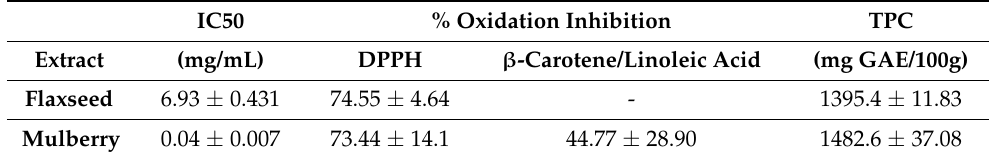
Antioxidant capacity by the percentage of oxidation inhibition (DPPH and β - carotene/linoleic acid) and total phenolic compounds (TPC) of flaxseed and mulberry extracts. IC50: inhibitory concentration (mg/mL). TPC: total phenolic compounds. DPPH: 2,2 (cid:48) -Diphenyl-1- Picryl-Hydrazil. GAE: gallic acid equivalents. The values represent the means ± standard deviation.